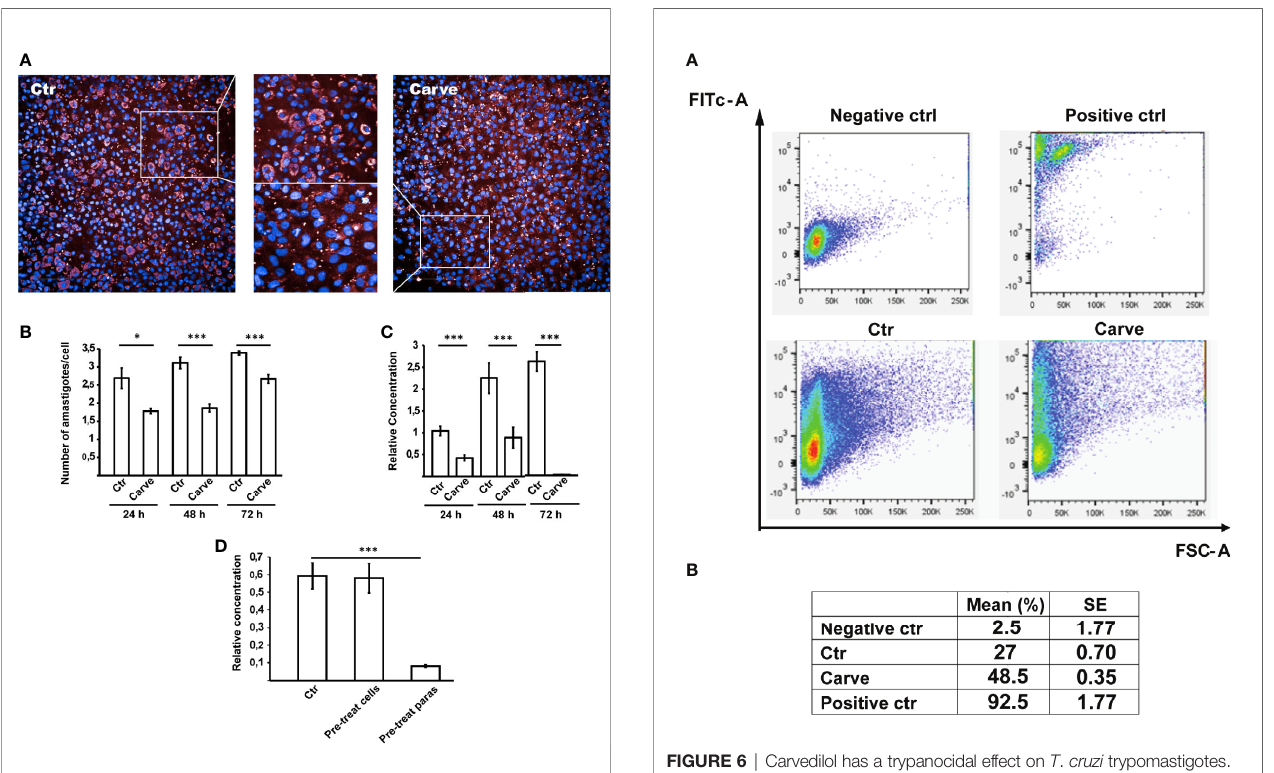
FIGURE 5 | Opera Phenix system and qPCR analysis con fi rmed action of carvedilol in vitro. HG39 cells were infected with trypomastigotes of T. cruzi Tulahuen strain (MOI=10) for 24 hours and treated with 10 m M carvedilol for 24, 48 and 72 h (Carve) or DMSO (Ctr). (A) confocal images of each condition taken by the system. (B) Number of amastigotes/cell in each group at the indicated times. Data are shown as mean +/- standard error of 3 independent experiments. *p < 0.05, ***p < 0.001 (Tukey test). A total of 100 cells per group was counted. (C) Relative concentration of T. cruzi DNA in each condition detected by dual-labeled qPCR. Data are shown as mean +/- standard error of 3 independent experiments. ***p < 0.001 (Tukey test). (D) Parasite load of HG39 cells infected for 24 h with trypomastigotes of T. cruzi Tulahuen strain (MOI=10) previously treated with 10 m M carvedilol for 24 h were compared to cells infected in control conditions (DMSO) or cells pre- treated with 10 m M carvedilol before infection with T. cruzi Tulahuen strain (MOI=10). Data are shown as mean +/- standard error of 3 independent experiments. ***p < 0.001 (Tukey test).